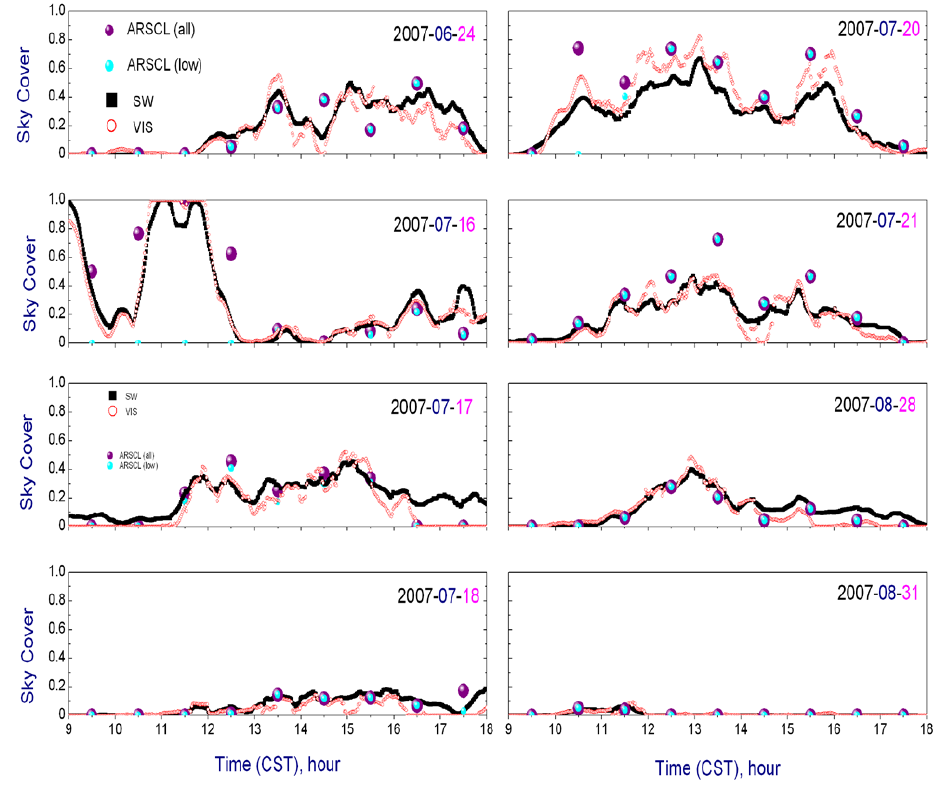
Fig. 6. Same as Fig. 5 but for 8